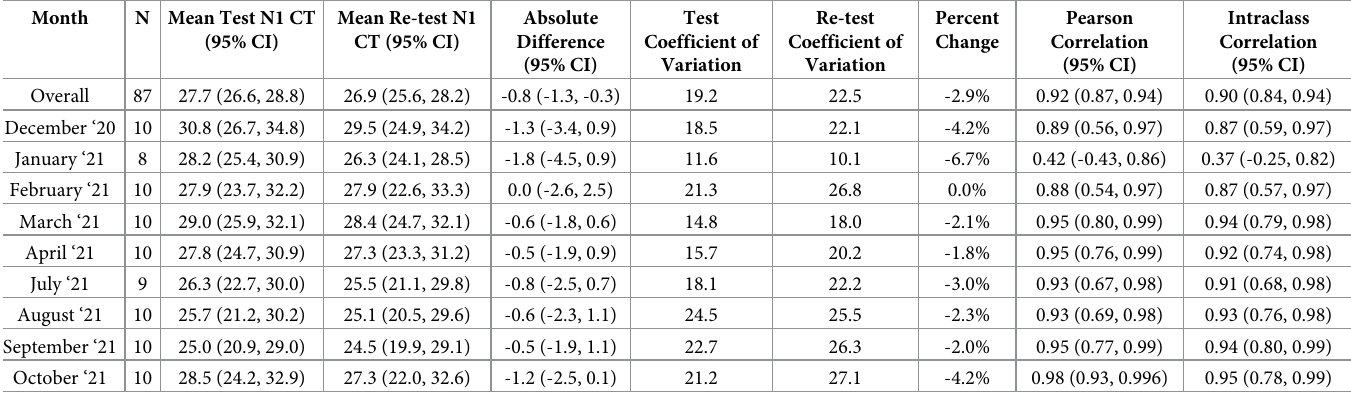
Table 1. Test and re-test Ct value differences by month.